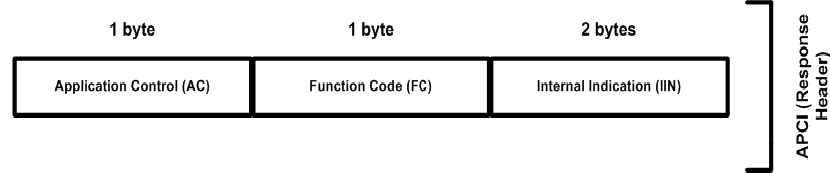
Figure 4. Response-header structure.